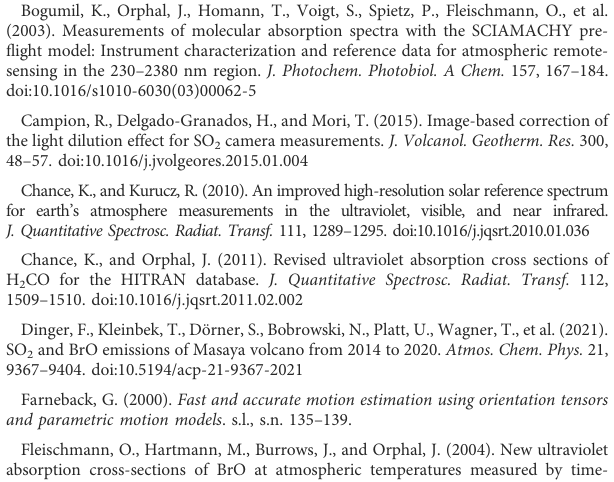
SUPPLEMENTARY FIGURE S1 PlotofthedetectionlimitinvestigationoftheBrOcamerashowingthe1- σ -pixel- pixel standard deviation of the IFPICS AA σ AA in a plume-free background sky regionasafunctionoftheintegrationtime.Therightx-axisshowstheBrOCD calibrated with the IFPICS model giving the detection limit of the BrO camera.